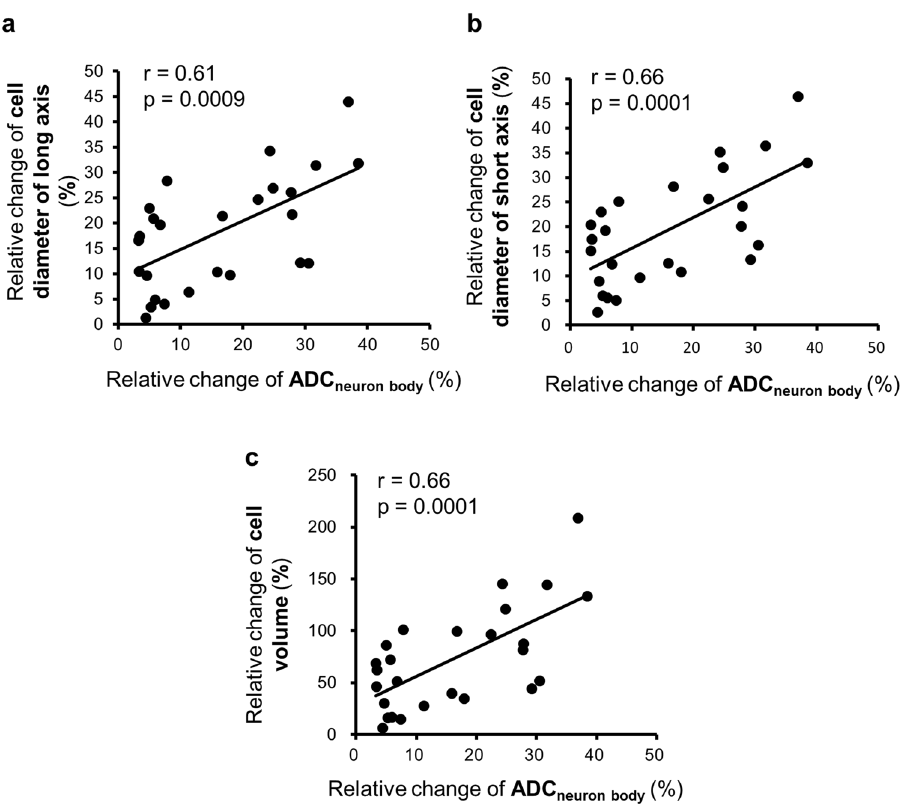
Figure 4. The cellular ADC increase was correlated with the cell size change. Scatter plots showing a correlation between the relative ADC change and the relative change of cell diameter of long axis ( a ), short axis ( b ) and cell volume ( c ) in neuron bodies of B1, B2, B6, and B9. 26 neurons of B1, B2, B6, and B9 in 4 Aplysia . Straight lines are intended to show the correlations between intracellular ADC and axes, Methods Tissue preparation of Aplysia buccal ganglia. Seven juvenile Aplysia californica (National Resource for Aplysia ; Miami, FL, USA) were used in total. On three samples we performed only MR microscopy while on the other four we also acquired optical images. Aplysia were anesthetized by injection of an isotonic magnesium chloride solution (360 mM MgCl 2 and 10 mM HEPES, pH = 7.5). The animals were dissected on a sylgard-coated petri dish (Dow Corning; Midland, MI, USA) filled with cold ASW (450 mM NaCl, 10 mM KCl, 30 mM MgCl 2 , 20 mM MgSO